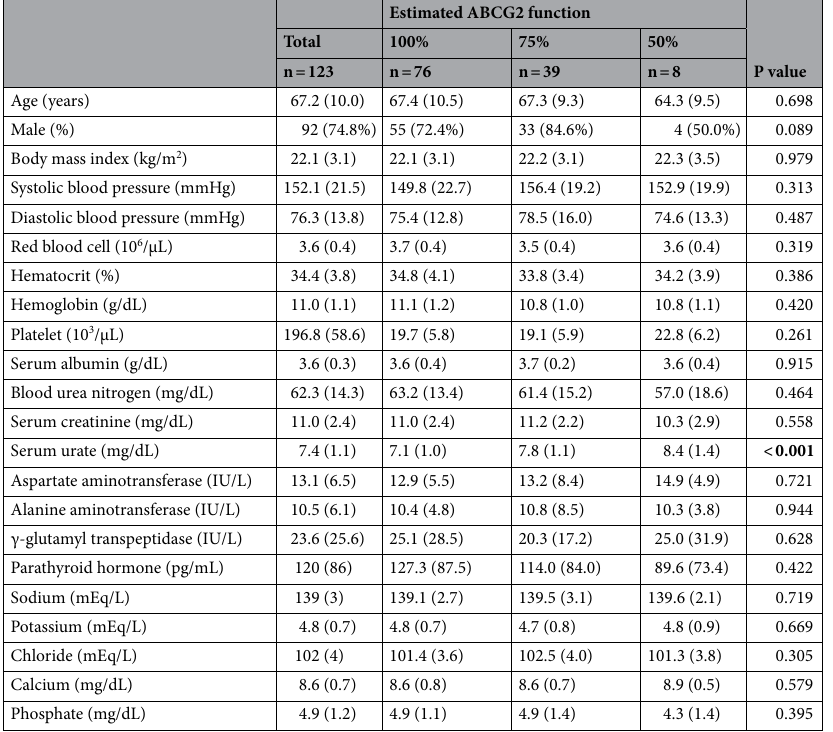
Table 1. Clinical characteristics of hemodialysis participants. Significant values are in bold. The values represent the mean (standard deviation or proportion) immediately before the start of hemodialysis with a 2-day interval.